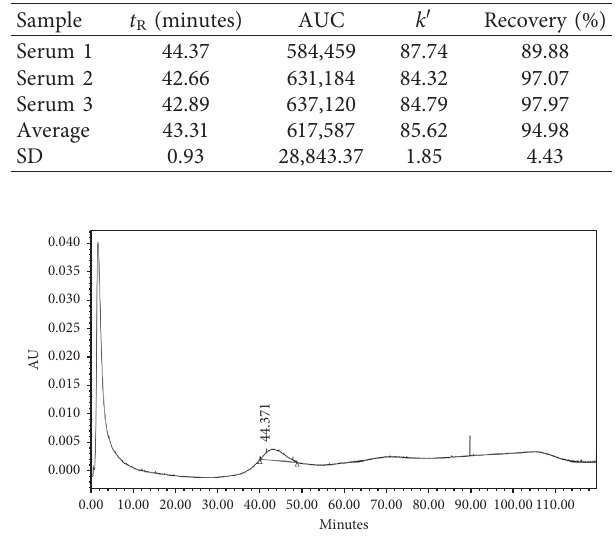
Figure 11: Chromatogram of atenolol in the serum using the MIP 1 monolithic column.